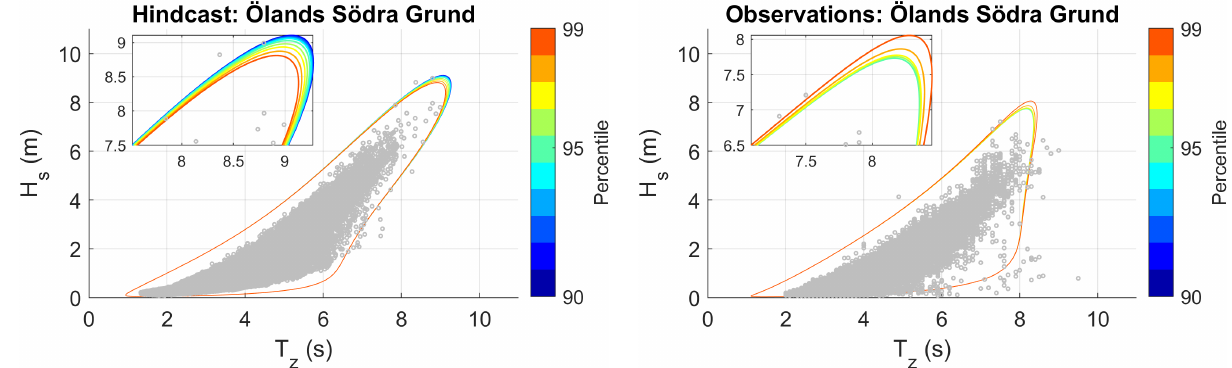
Figure 6. Sensitivity analysis for the hybrid fit (Equation (2)) for H s in the I-FORM method for 50-year contours. As explained in the text, a percentile of H s is chosen which affects the choice of the threshold η . The region with the largest contour variability is enlarged to more clearly show the colors. Only data from Ölands Södra Grund is